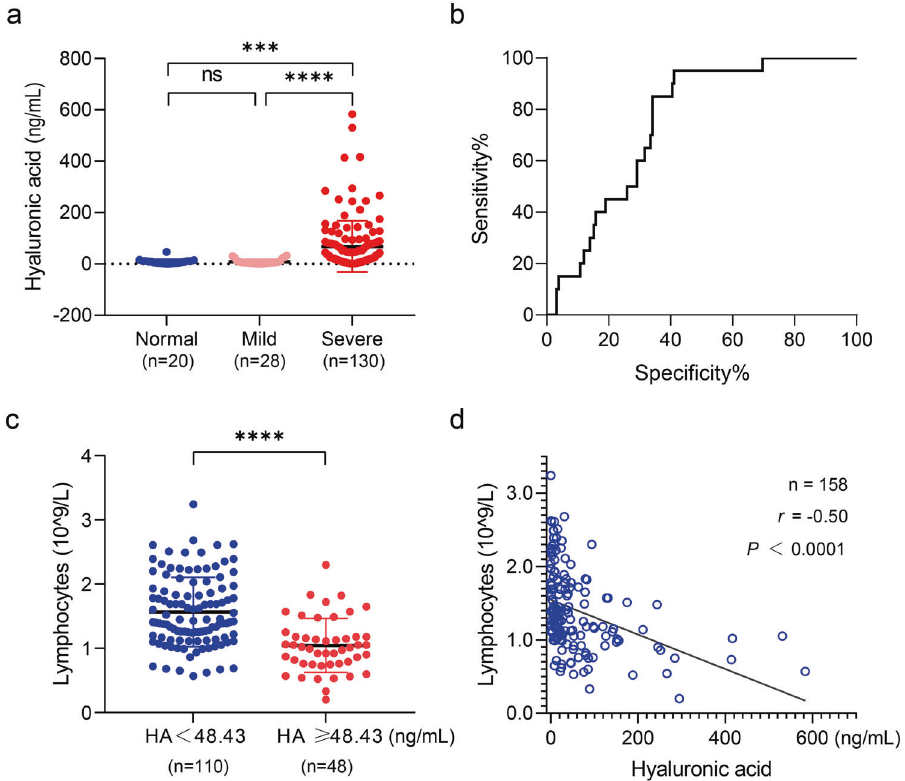
Fig. 1 The increase of hyaluronan is related to the severity in COVID-19 patients. a The plasma hyaluronan level of COVID-19 patients and normal healthy subjects were evaluated by ELISA. The classi fi cation of mild and severe of COVID-19 was based on pulmonary lesions of chest CT. b ROC of the plasma hyaluronan level in normal volunteers and COVID-19 patients. The 48.43 ng/mL of hyaluronan is the cutoff value to distinguish the normal subjects and COVID-19 patients. c Counts of lymphocytes upon admission plotted against hyaluronic acid. d Two-tailed Spearman ’ s correlation analysis was performed to evaluate the correlation between hyaluronan and lymphocyte counts. Data are presented by mean ± SD. The signi fi cant difference in ( a ) and ( c ) was analyzed by the Mann – Whitney test. * P < 0.05; ** P < 0.01; *** P < 0.001; **** P < 0.0001; ns, not signi fi